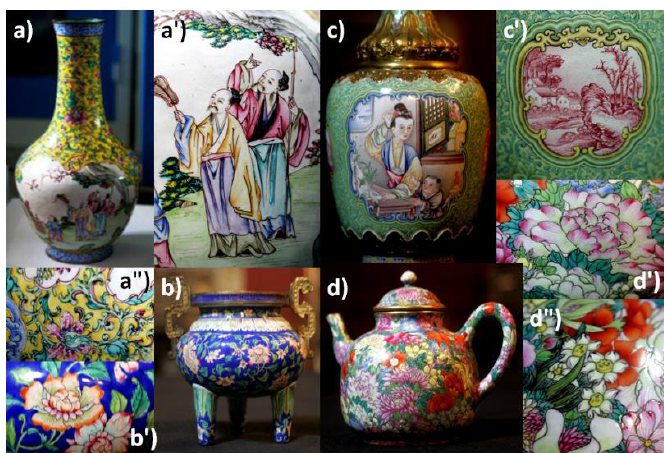
Figure 4. Chinese painted enamelled metal and porcelain wares: ( a ) R975 (18th century, a′ and a′′ detail of the decor); ( b ) F1698C (18th century, b′ detail); ( c ) F1440C (18th century, c′ detail of the medallion); ( d ) F1429C (18th century porcelain, d′ and d′′ details).